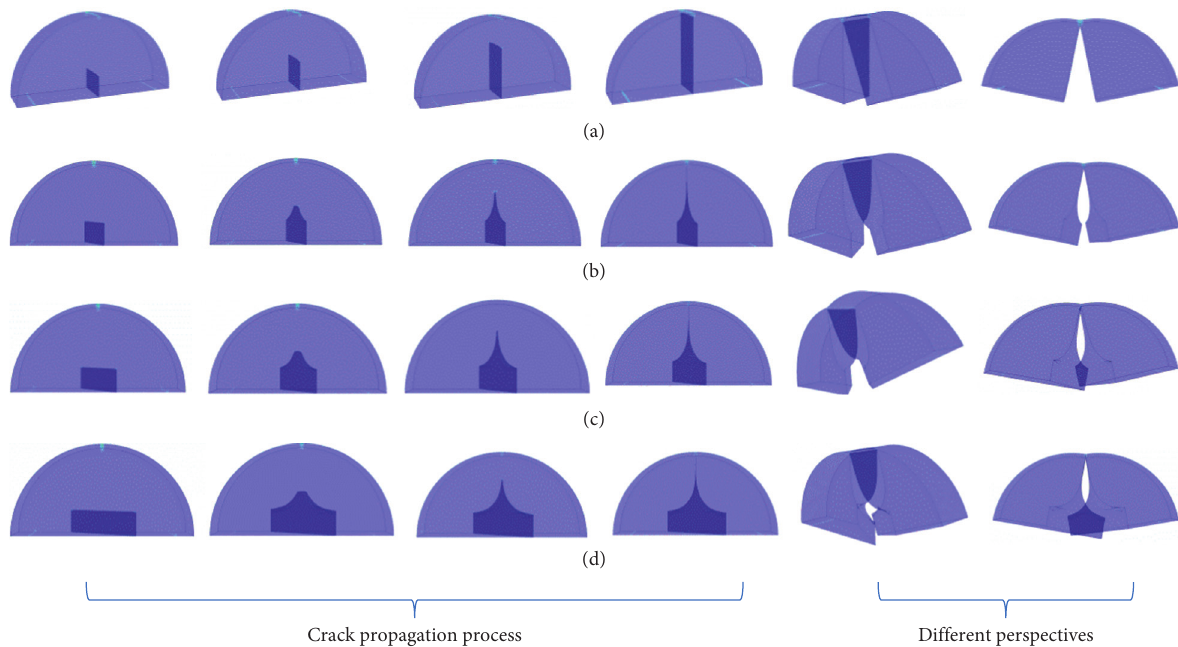
Figure 11: Entire process of crack growth path. (a) Pure mode I with α � 0 ° . (b) Mixed mode I/III with α � 30 ° . (c) Mixed mode I/III with α � 45 ° . (d) Mixed mode I/III with α � 60 ° .